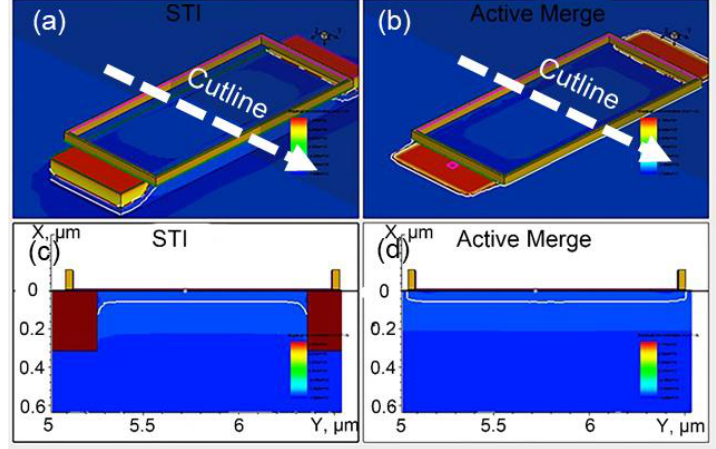
Figure 10. TCAD simulation structure of a single transistor with ( a ) STI and ( b ) merged active area. ( c , d ) are the cross-sections at the corresponding cutline in ( a , b ).